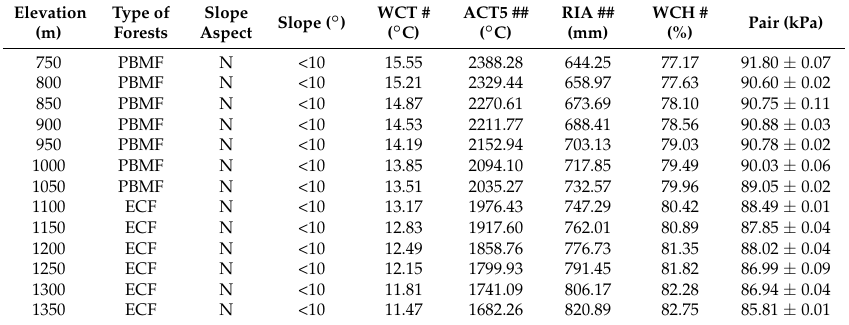
Table 1. General description of plots at various elevations on Changbai Mountain.